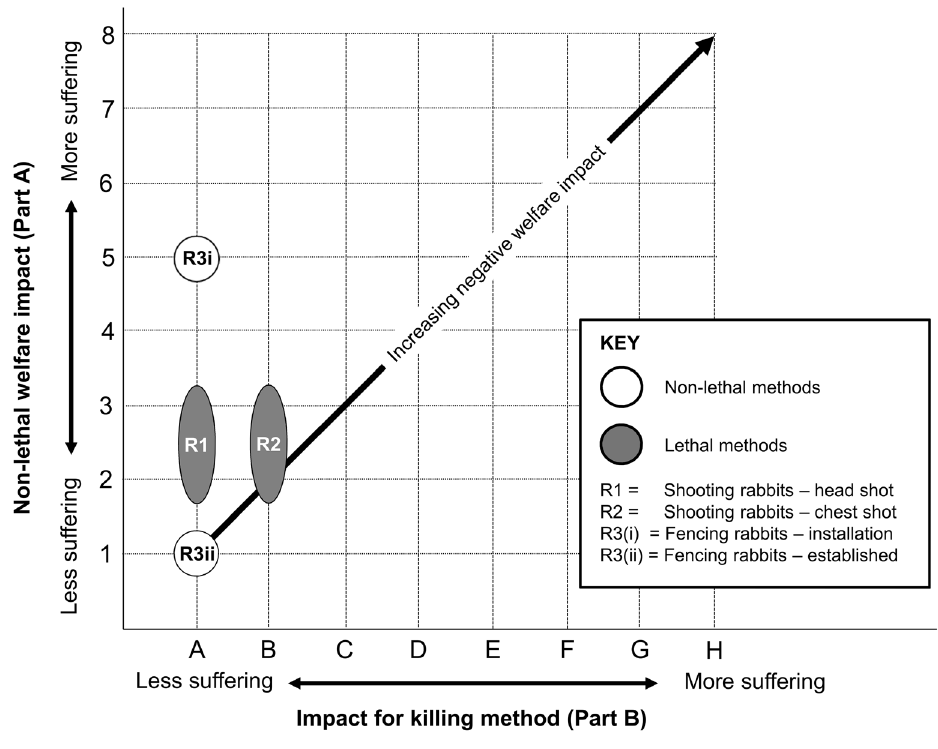
Fig 1. Welfare assessment grid for rabbit management